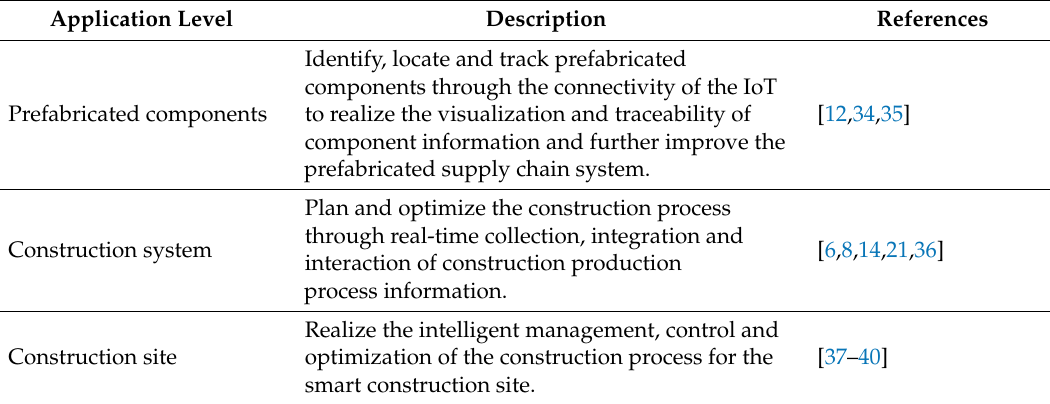
Table 1. The application of Internet of Things (IoT) in di ff erent levels in prefabricated buildings. Application Level